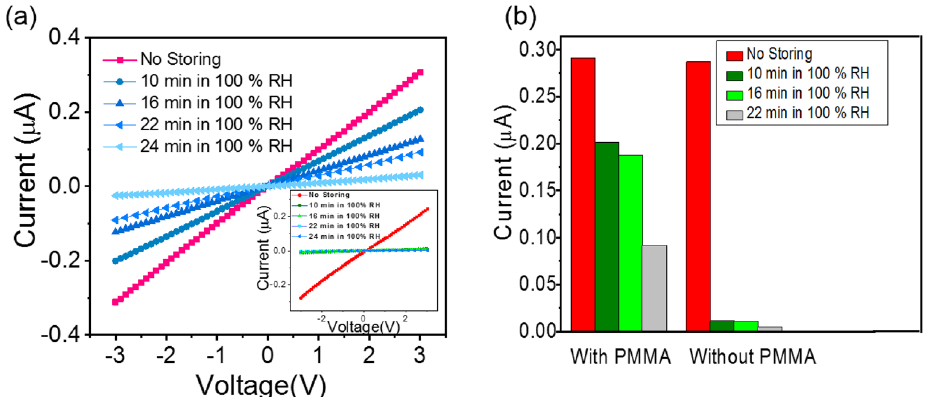
Figure 7. Stability test of the SnS 2 /TCLP photodetector. ( a ) I–V graph of planar SnS 2 /TCLP/PMMA photodetector, the inset graph shows the I–V result of unprotected SnS 2 /TCLP photodetector for different times storing from 0 to 24 min. ( b ) The trend of maximum current of protected and unprotected photodetectors with and without PMMA layer keeps for different times of 0, 10, 16, 22 min, under 100% humidity and room temperature; the light illumination is 445 nm with 5 mW/cm 2